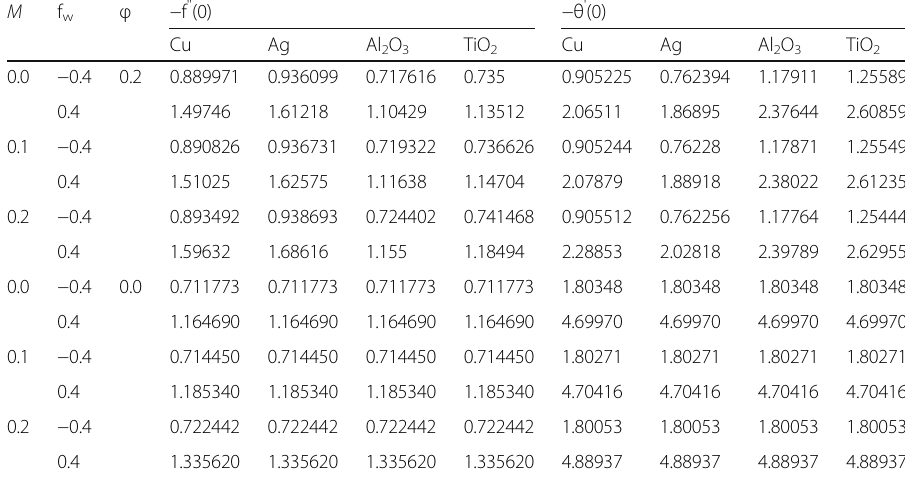
Table 4 Values of − f '' (0) and − θ ' (0) for various M, f w and φ with γ = π /3, Pr = 6.785, A = B = λ = 0.5, S =